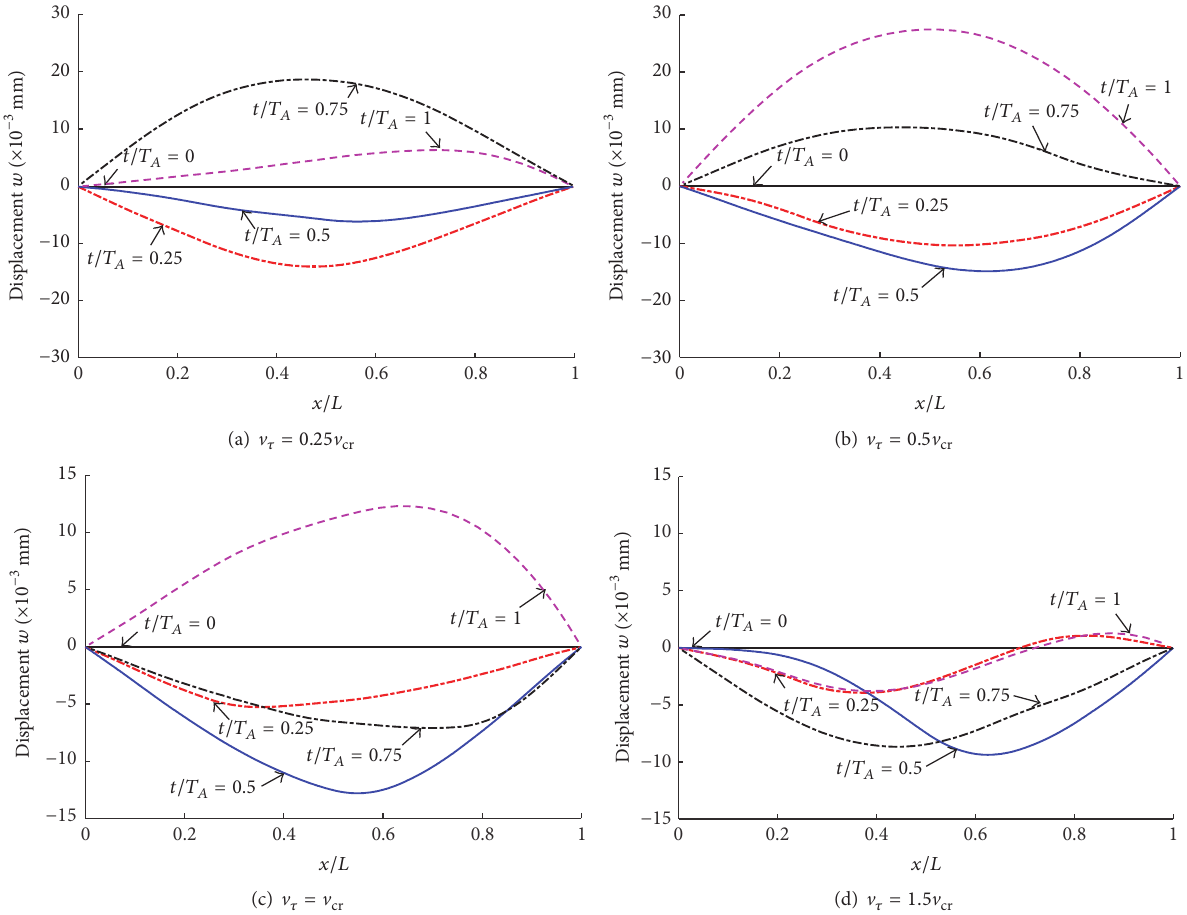
Figure 6: Deformed shapes of a simply supported Timoshenko beam at five different times ( 𝑡/𝑇 𝐴 = 0, 0.25, 0.5, 0.75, and 1) when the beam is subjected to a point bending moment moving at four different constant speeds: (a) V 𝜏 = 0.25 V cr ; (b) V 𝜏 = 0.5 V cr ; (c) V 𝜏 = V cr ; (d) V 𝜏 = 1.5 V cr , where V cr is the lowest critical